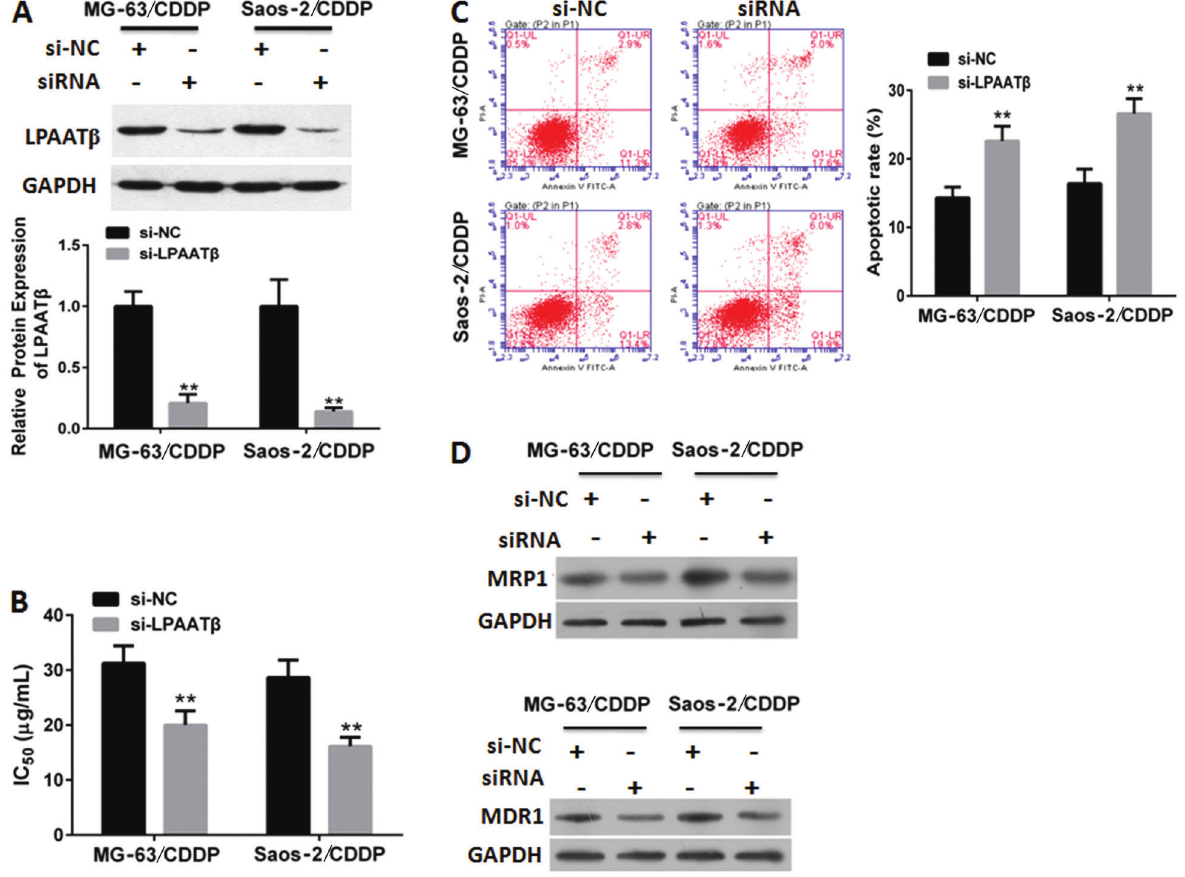
Figure 5. Effect of silencing LPAAT b on cisplatin (CDDP) resistance. A , Relative protein expression of LPAAT b in MG-63/CDDP and Saos-2/CDDP cells transfected with siRNA or normal control (NC). B , Silencing LPAAT b decreased IC 50 of CDDP in MG-63/CDDP and Saos-2/CDDP cells. C , Silencing LPAAT b increased CDDP-induced apoptosis in MG-63/CDDP and Saos-2/CDDP cells. Data are reported as means ± SD. **P o 0.01, compared to its respective control (Student ’ s t -test). D , Silencing LPAAT b decreased the expression of MRP1 and MDR1 in MG-63/CDDP and Saos-2/CDDP cells exposed to